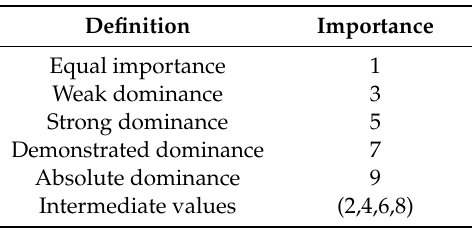
Table 1. Saaty’s importance